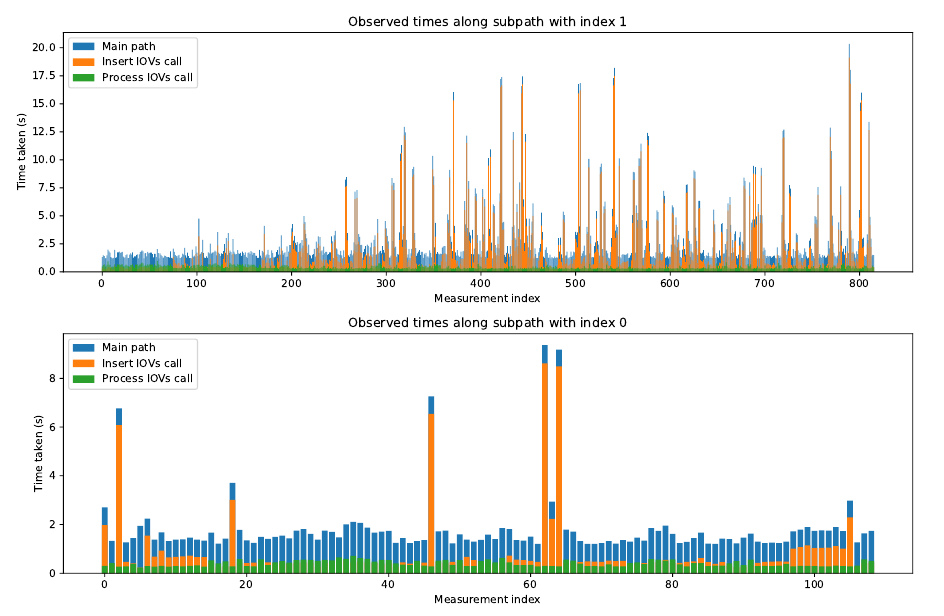
Figure 1. Plots of the time taken to get from one statement in code to another. Each plot contains measurements taken along a distinct path. The measurement index is the index of the measurement in the set derived for the particular